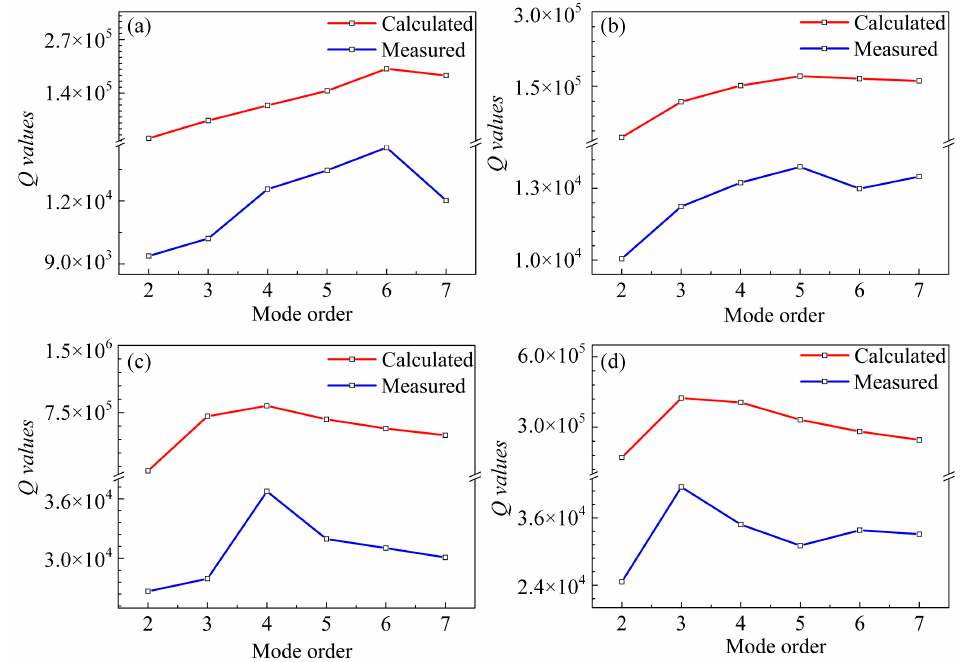
Figure 7. The comparison between the theoretical and measured Q values for the 37 and 18 μ m-radius resonators in air ( a , b ) and vacuum ( c , d ).